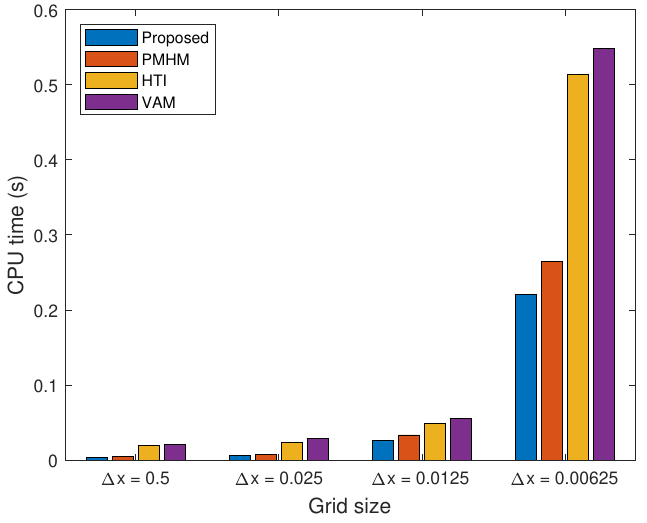
Figure 11. The CPU time for the proposed methods and the PMHM, HTI, and